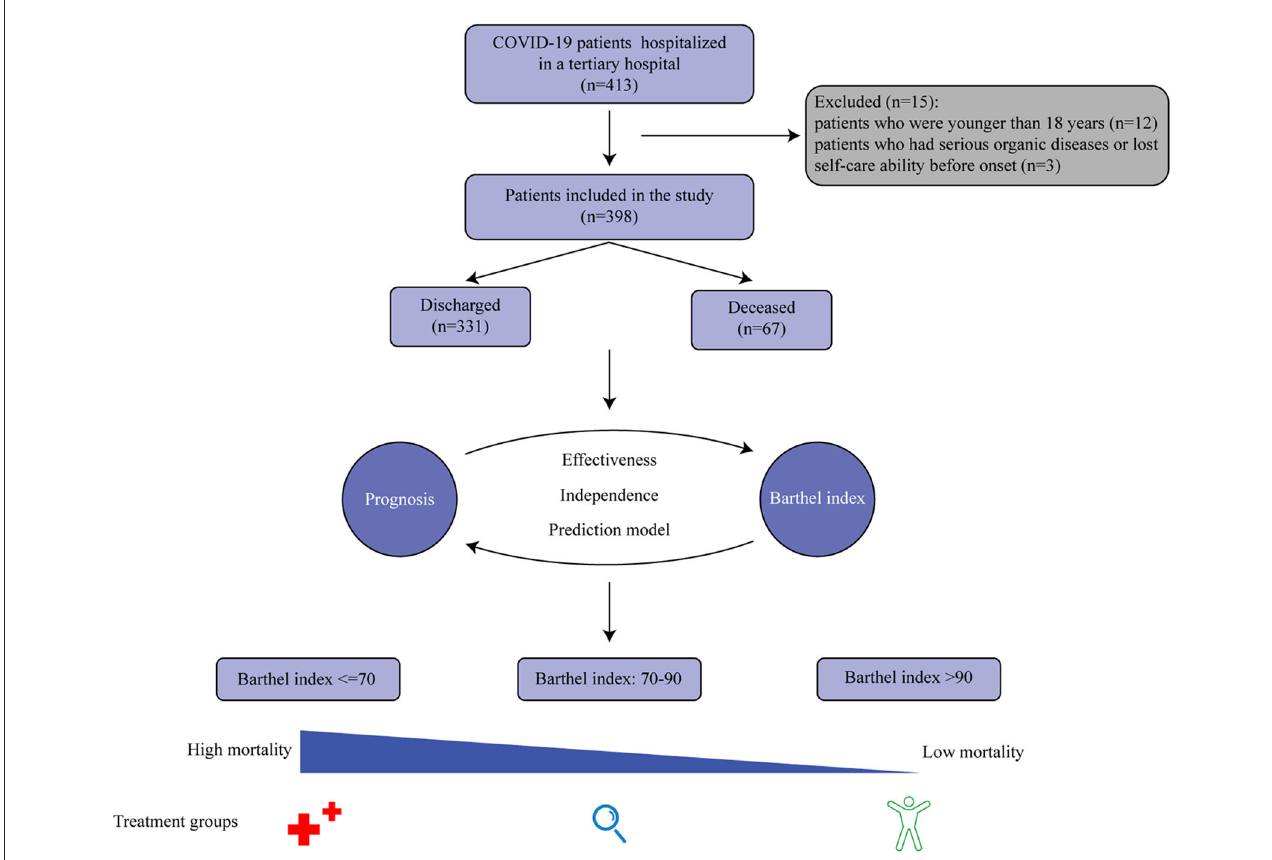
FIGURE1 A graphical abstract of the study. The Barthel Index is significantly associated with the prognosis of COVID-19 patients, and a three-group classification scheme based on the index has been developed to facilitate disease